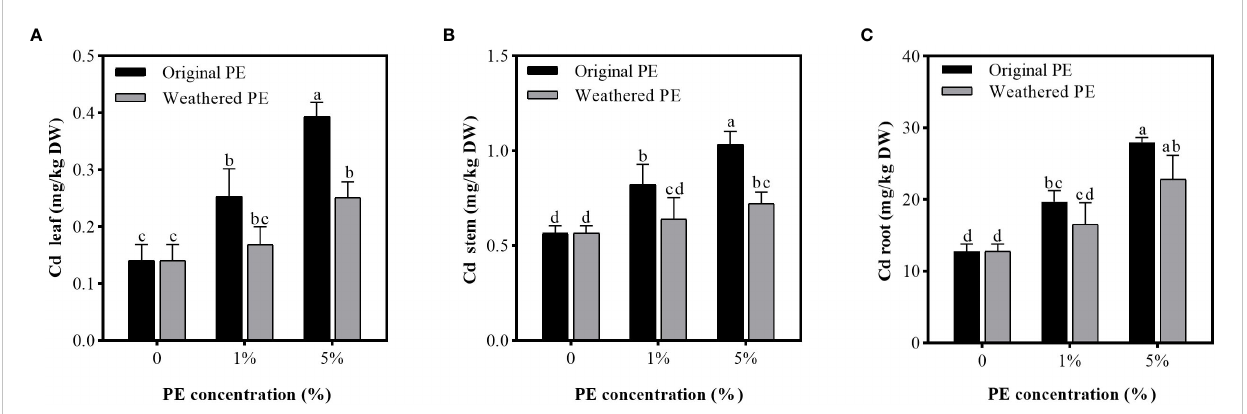
FIGURE 2 Cd concentration in the leaf (A) , stem (B) , and root (C) of sweet potato planting in PE MPs and Cd compound-contaminated soil. Plant samples are collected after been treated by original or weathered PE MPs (0, 1% and 5%) for 15 days. Different letters in each fi gure indicate signi fi cant (p < 0.05) differences according to Tukey ’ s